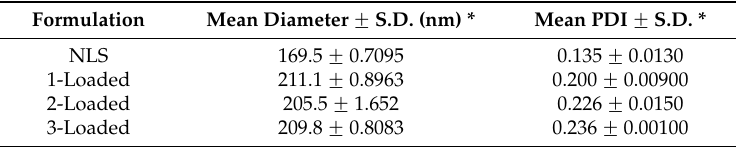
Table 1. Droplet size and polydispersion index of the nanostructured lipid system (NLS) and copper(II) complexes loaded into the NLS. Each value represents the average ( ˘ standard deviation) of three repetitions.